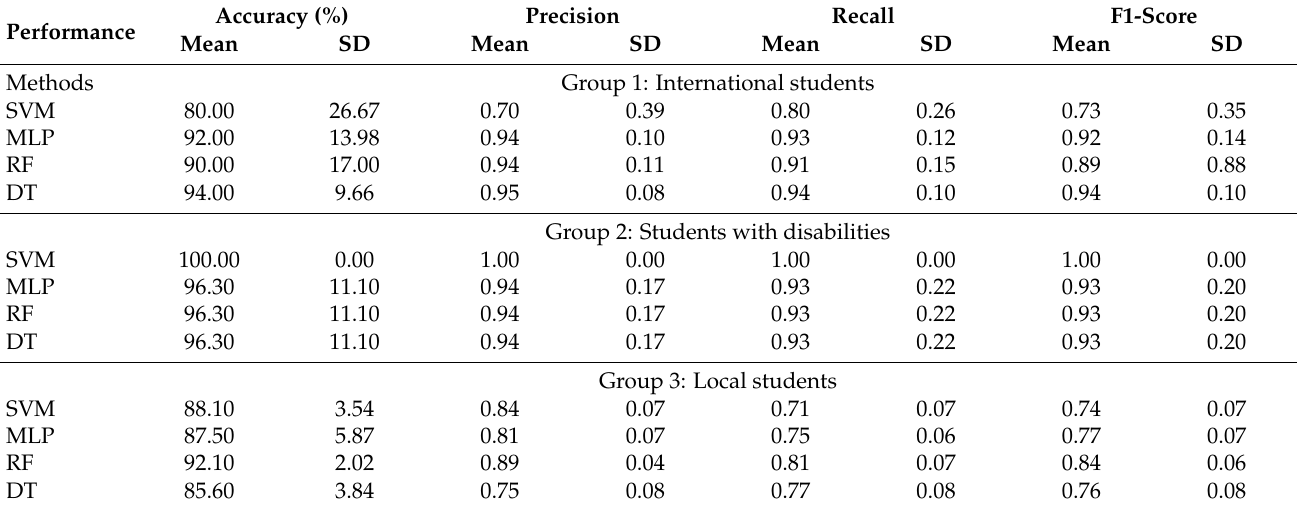
Table 3. Classification results of Case 2 (Minority focus and combination (MFC)).